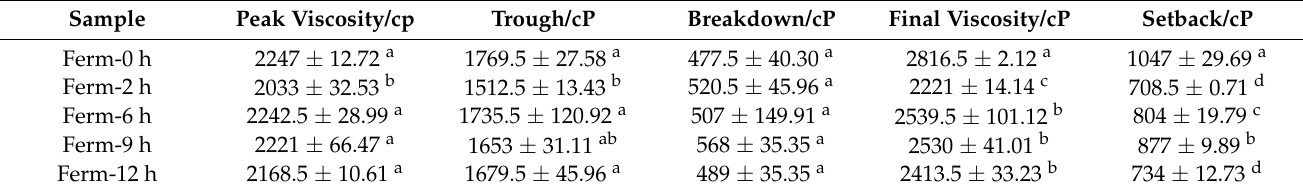
Table 2. Pasting properties of wheat starch separated from bifidobacteria-fermented dough at different fermentation